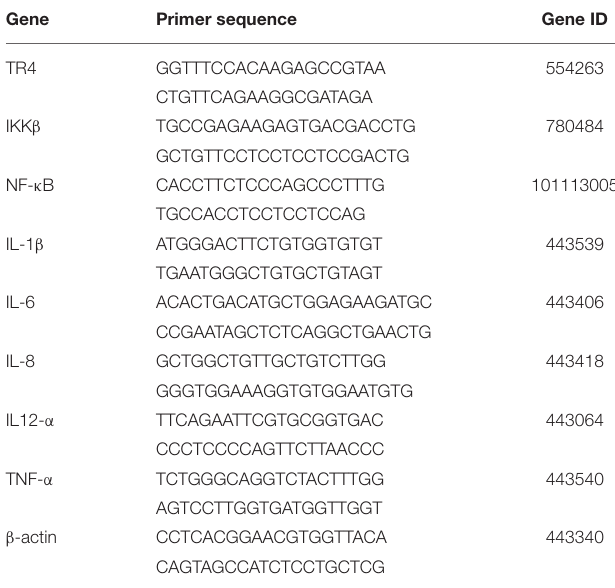
TABLE 1 | Gene-special primers used for